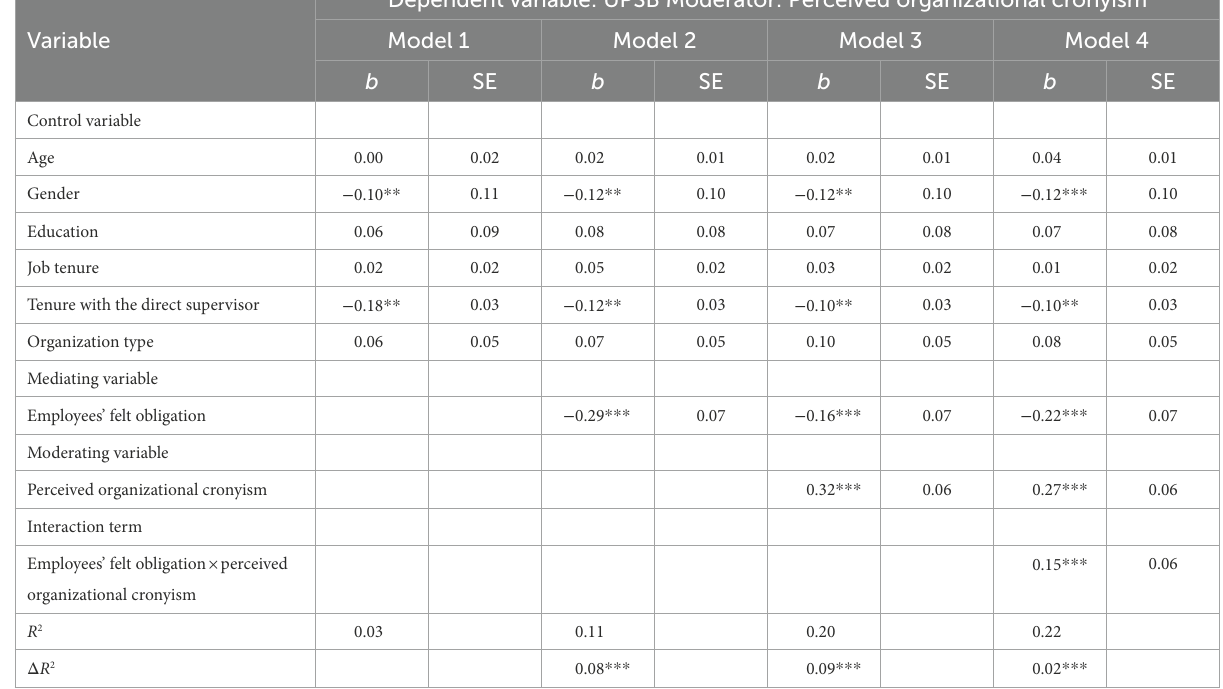
TABLE 4 Moderating effect of organizational cronyism.